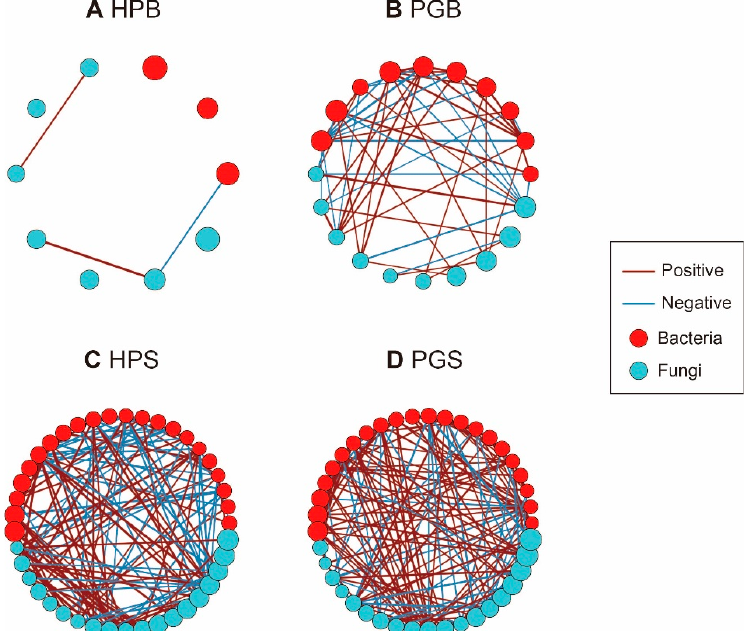
Figure 4. Co-occurrence network analysis of bark and soil microbial community according to gummosis. ( A ) HPB, ( B ) PGB, ( C ) HPS, and ( D ) PGS. Each network structure contains 10, 20, 41, and 41 nodes and 3, 55, 137, and 168 edges, respectively. Nodes and edges indicate microbial genera and significant correlations. The colors of nodes and edges represent the corresponding phyla and the direction of the relationship.